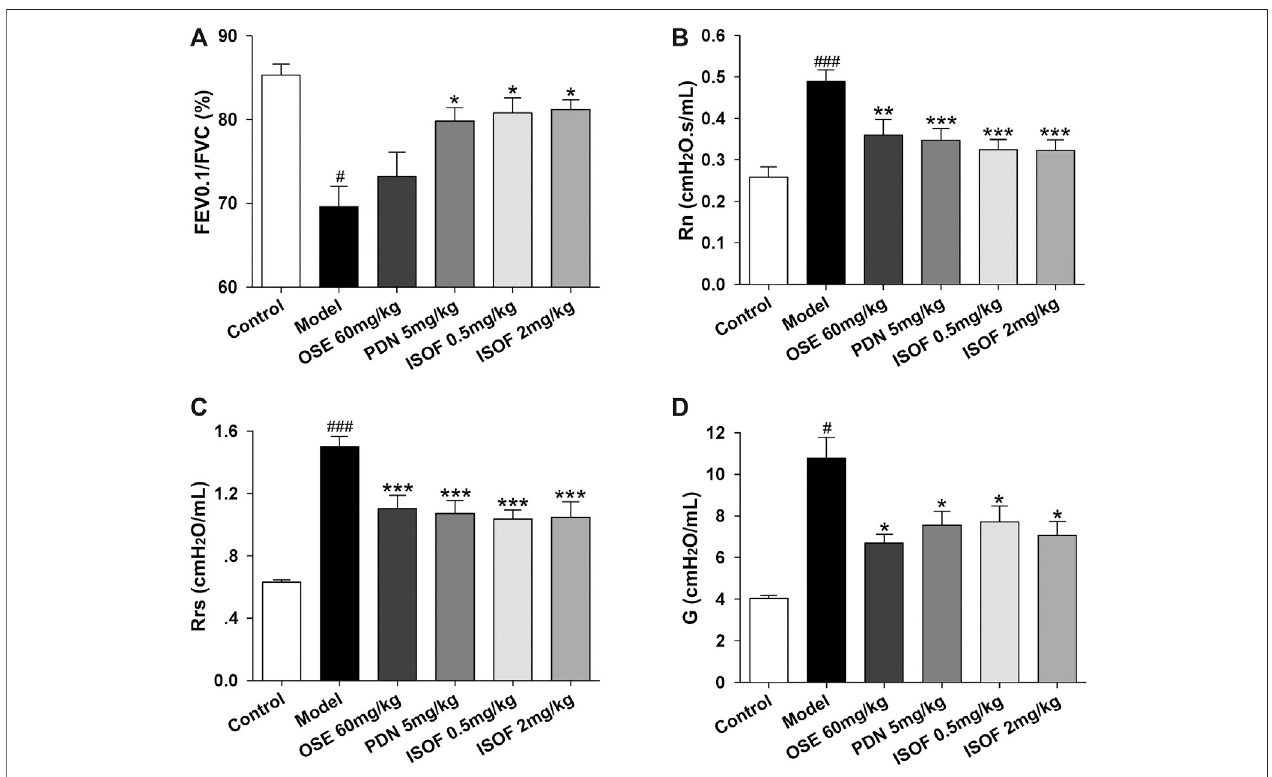
FIGURE 3 | ISOF improved the pulmonary function in AECOPD model mice. (A) Forced expiratory volume in 0.1 s/forced vital capacity (FEV0.1/FVC), (B) Newtonian resistance (Rn), (C) respiratory resistance (Rrs) and (D) tissue damping (G) in each group. Data are expressed as means ± SEM ( n (cid:1) 12 in each group). # p < 0.05 and ### p < 0.001 vs. control group; * p < 0.05, ** p < 0.01, and *** p < 0.001 vs. model